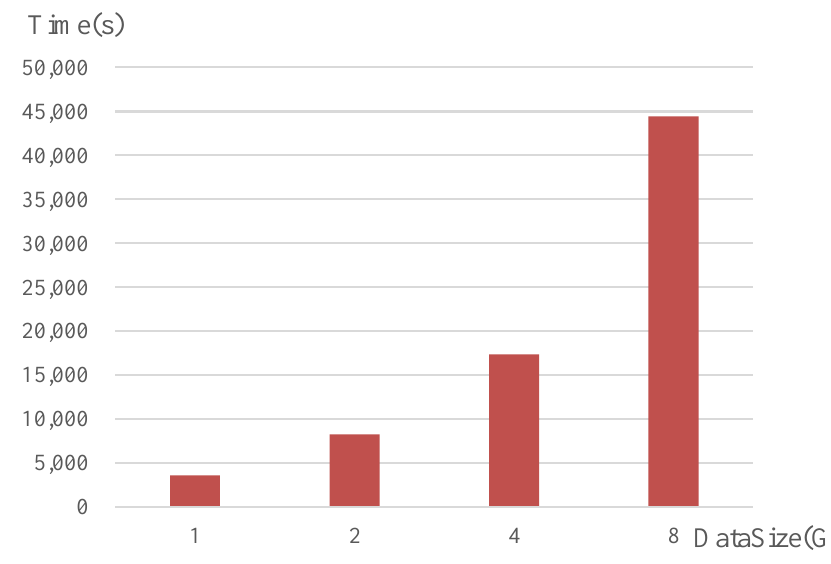
Figure 10. Speedups of DPA processing big HSIs with different data sizes.